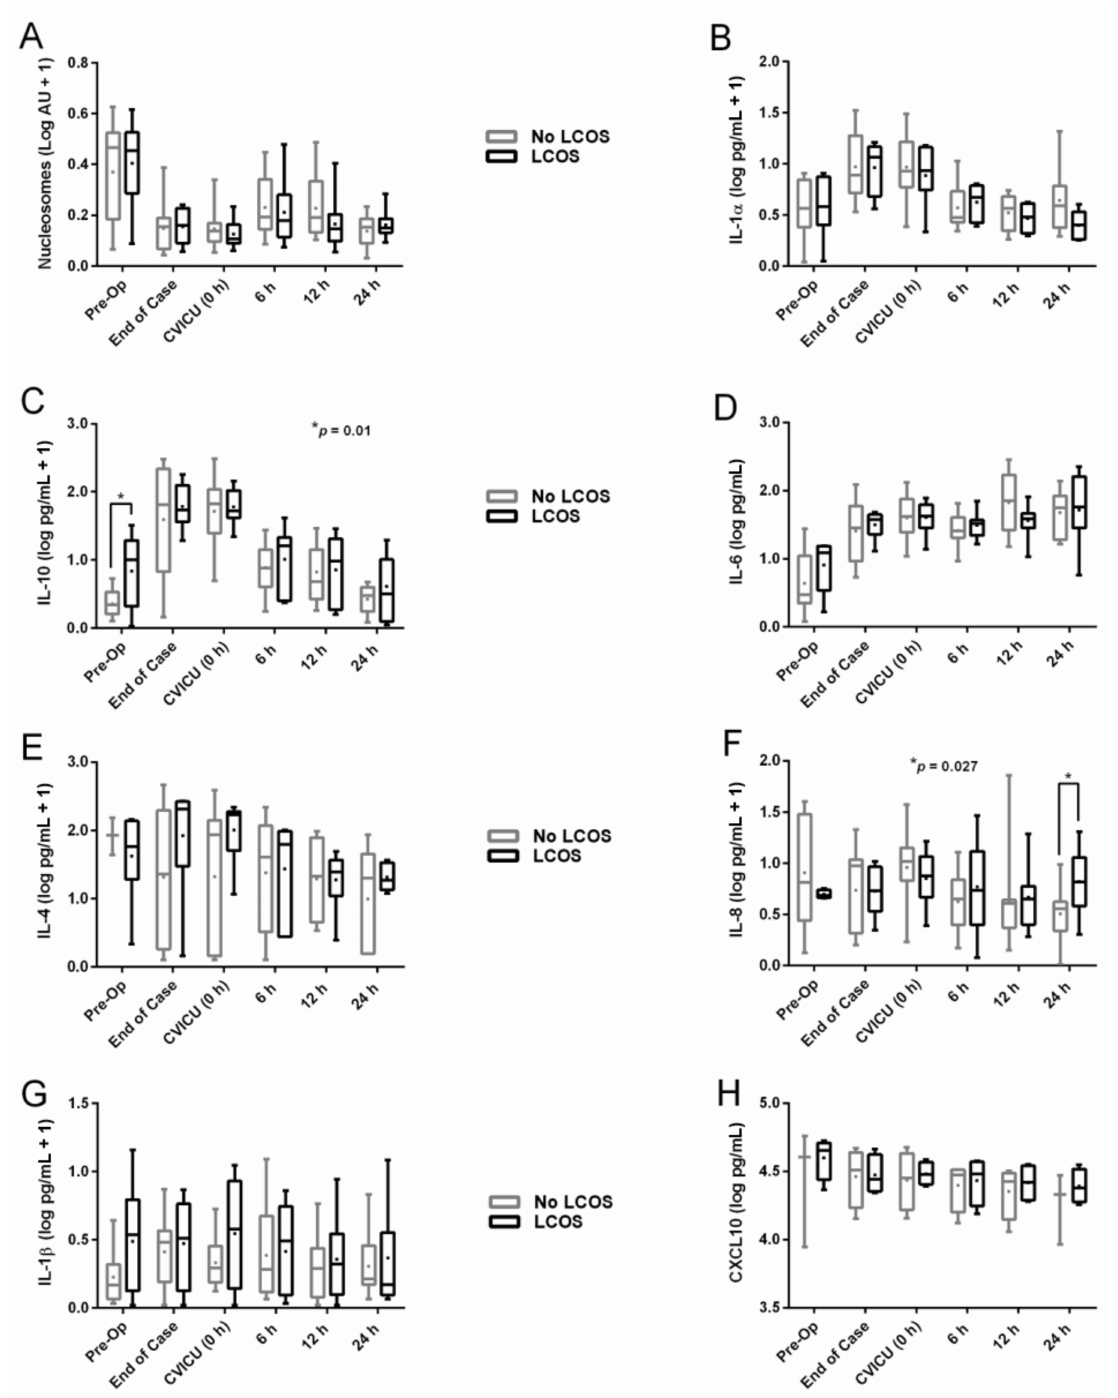
Figure 3. Group 2 serum cytokine and nucleosome levels (log-transformed) during the perioperative period stratified by LCOS status. ( A ), Circulating nucleosomes (log AU + 1). ( B ), IL-1 α (log pg/mL + 1). ( C ), IL-10 (log pg/mL + 1); * p = 0.01 (pre-op). ( D ), IL-6 (log pg/mL). ( E ), IL-4 (log pg/mL + 1). ( F ), IL-8 (log pg/mL + 1); * p = 0.027 (24 h). ( G ), IL-1 β (log pg/mL + 1). ( H ), CXCL10 (log pg/mL). Whiskers extend to minimum and maximum values, box represents 25th to 75th percentiles, line indicates median, and + indicates mean. LCOS = low cardiac output syndrome, IL = interleukin, AU = arbitrary units, CVICU = cardiovascular intensive care unit, CXCL10 = C-X-C motif chemokine ligand